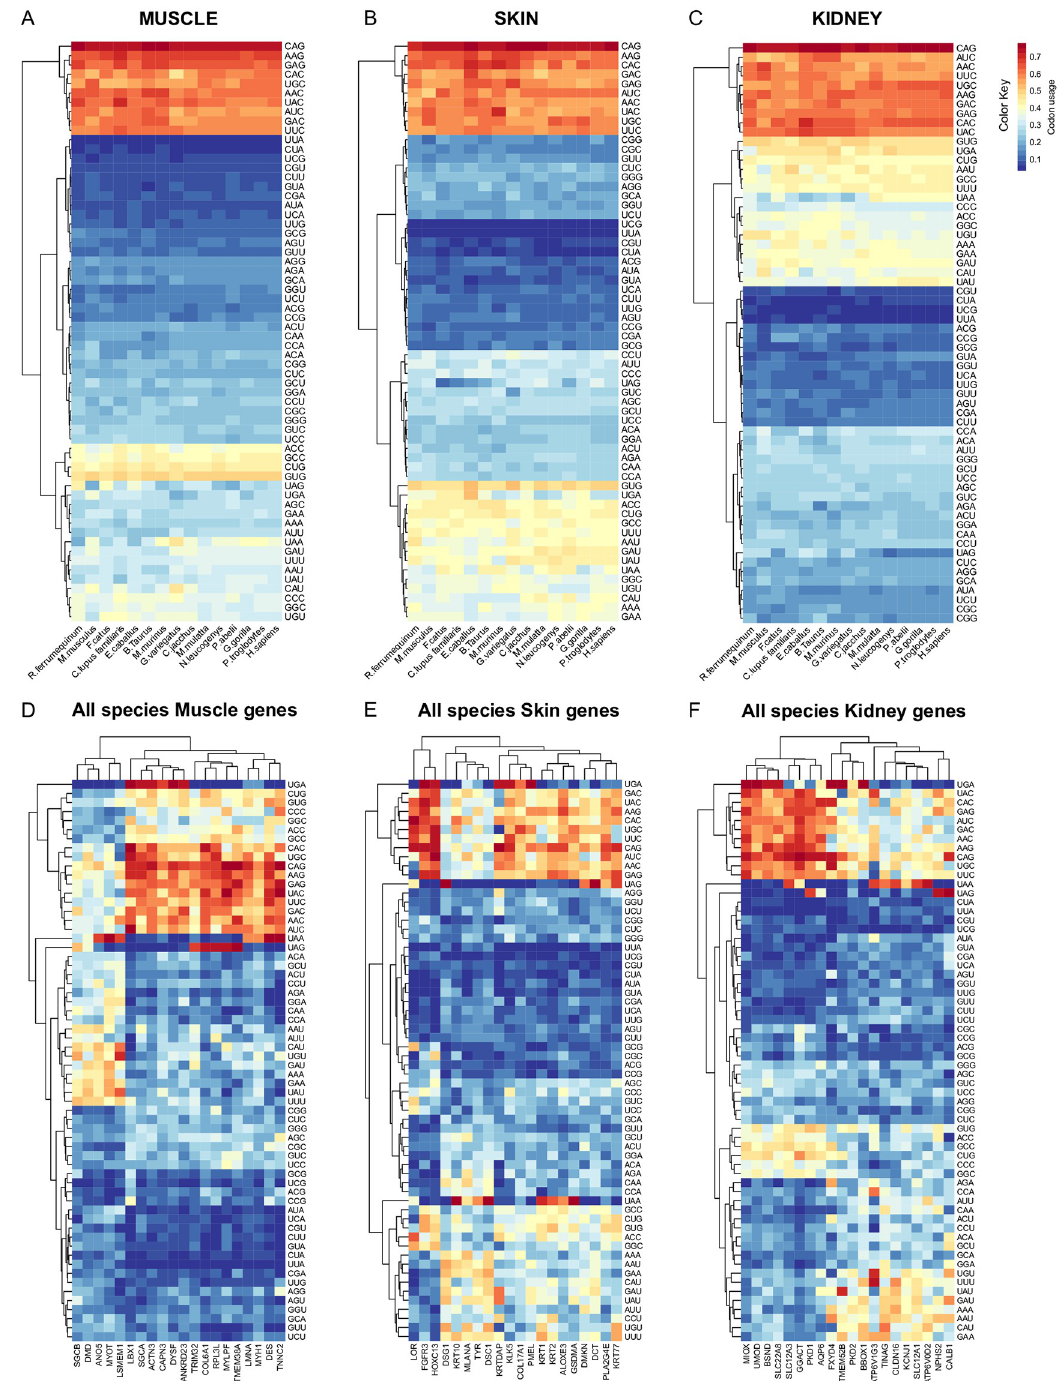
Fig 2. CU values across mammals. Heat plots were generated using R package gplots. Rows were clustered based on Euclidean distance. The color key of CU values varies from blue to red with low to high values of the CUB respectively. CU values in all 60 tissue-specific genes across 15 mammalian species in the metazoan phylogenetic tree are shown in panels A, B, and C, and CU values of single genes in all species are shown in panels D, E, and F. Tissue-specific CUB fingerprints are very evident with a conserved trend across mammals (panels A, B, C). Codons CAG, AAG, CAC, GAC, GAG, AUC, AAC, UAC, UGC, and UUC are the most frequently used codons (red spots) in all tissues and across mammals, while codons UUA, CUA, UCG, CGU, CUU, GUA, CGA, AUA, UCA, UUG, and GCG are the rarest codons (blue spots) in muscle and skin but not in kidney genes. Muscle (panel A) and skin (panel B) CUBs do have a similar fingerprint, although muscle gens have much more codons with lower CU values